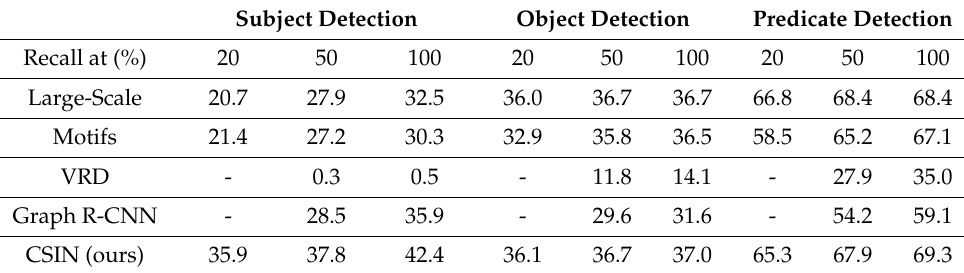
Table 6. Comparison results with other visual relationship detection